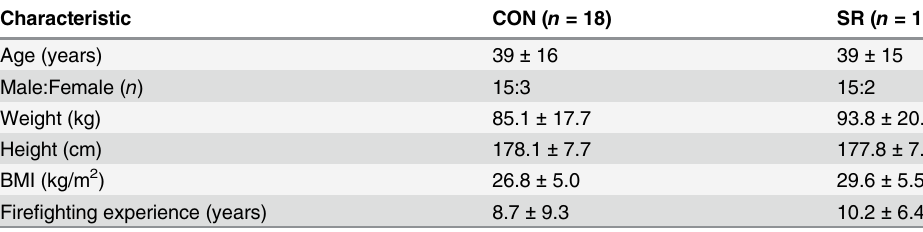
Table 1. Characteristics of participants in each condition (mean ± standard